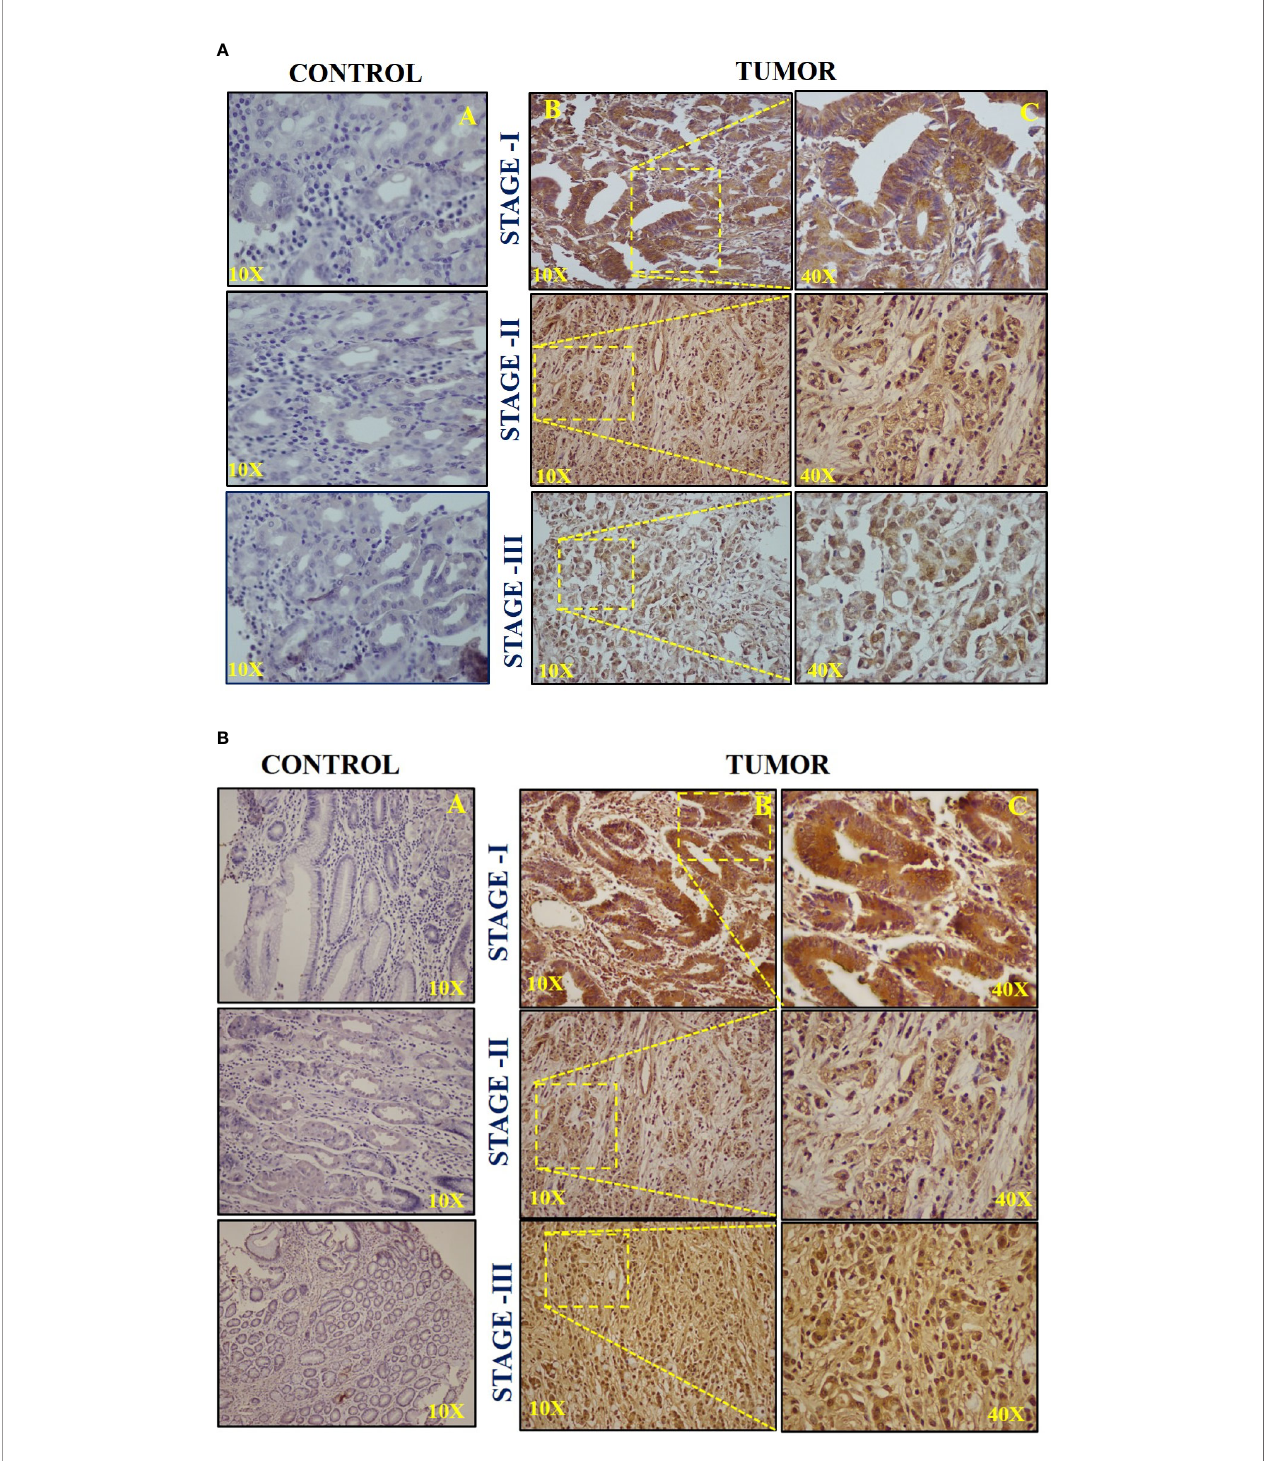
FIGURE 3 | (A) Representative images of immunohistochemistry (IHC) of c-Myc in (A) stage I, (B) stage II, and (C) stage III. (B) Representative images of immunohistochemistry (IHC) of hTERT in (A) stage I, (B) stage II, and (C) stage